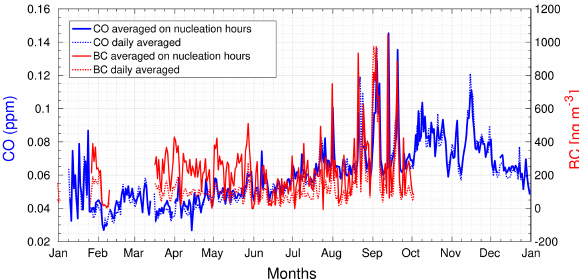
Figure 10. Annual variation in daily (doted lines) and between the − 2 / + 2 period around the nucleation onset (solid lines) of the BC (ngm − 3 ) and CO (ppm) concentration over the year